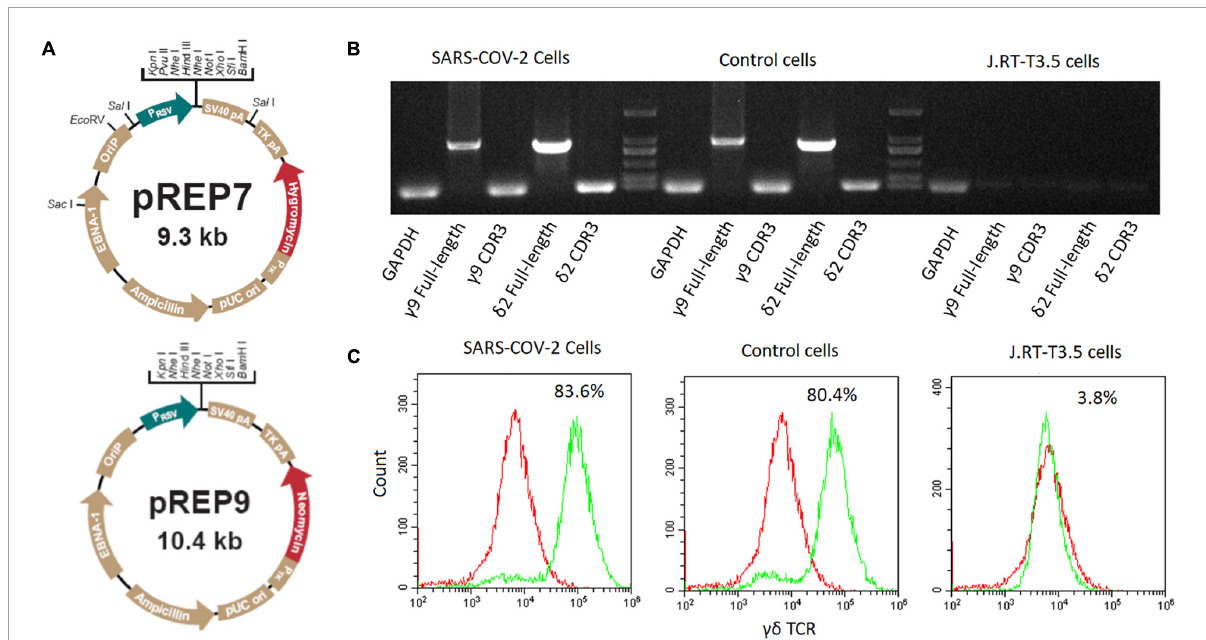
FIGURE1 Construction of SARS-CoV-2 specific γδ TCR transfected cells. (A) The map of pREP7 and pREP9 vectors. (B) Detection of γδ TCR expression by PCR in transfected J.RT3-T3.5 cells. mRNA was extracted from transfected cells and reverse transcribed into cDNA. The full-length γ 9 and δ 2 chains and their CDR3 sequences were amplified by using specific PCR primers. (C) Detection of γδ TCR expression by FACS analysis in J.RT3-T3.5 transfected cells. The cells were stained with FITC-labeled γδ TCR antibody and then analyzed by flow cytometry on a MoFlo XDP flow cytometer. The results are representative of three independent experiments. SARS-CoV-2 cells: SARS-CoV-2 specific γδ TCR transfected J.RT-T3.5 cells; Control cells: healthy controls’ γδ TCR transfected J.RT-T3.5 cells. J.RT-T3.5 cells: J.RT-T3.5 cells without plasmid